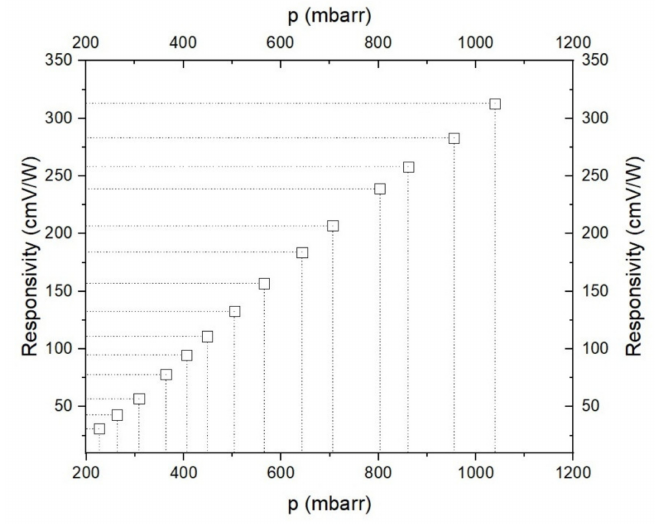
Figure 4. The responsivity of the photoacoustic cell.